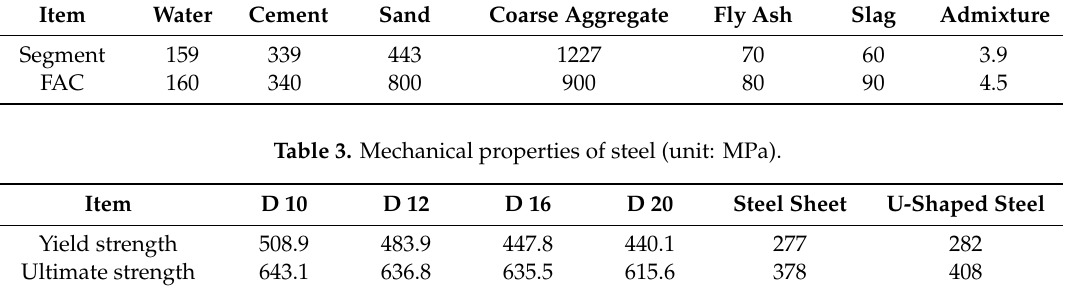
Table 2. Mix proportion of the concrete (unit: kg / m 3 ).